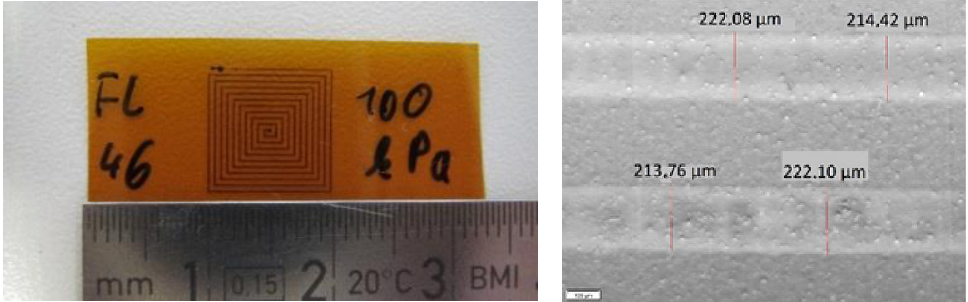
Figure 3. Width of polymer lines applied with dispenser printing.